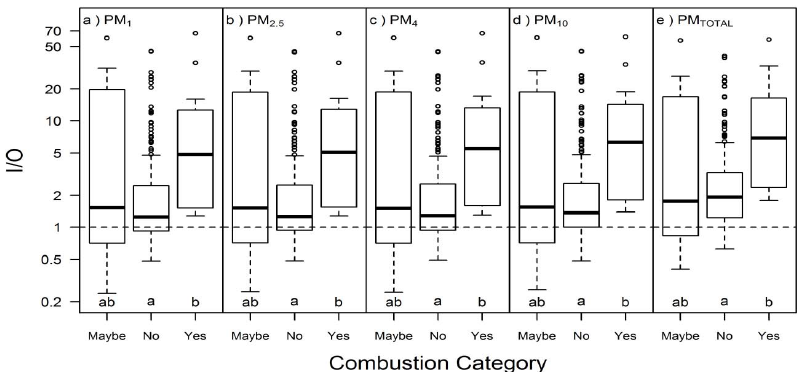
Figure 4. Boxplots of I/O in Building E (both campaigns) for ( a ) PM 1 , ( b ) PM 2.5 , ( c ) PM 4 , ( d ) PM 10 , and ( e ) PM TOTAL based on investigator ‐ observed combustion activities during measurements: yes =